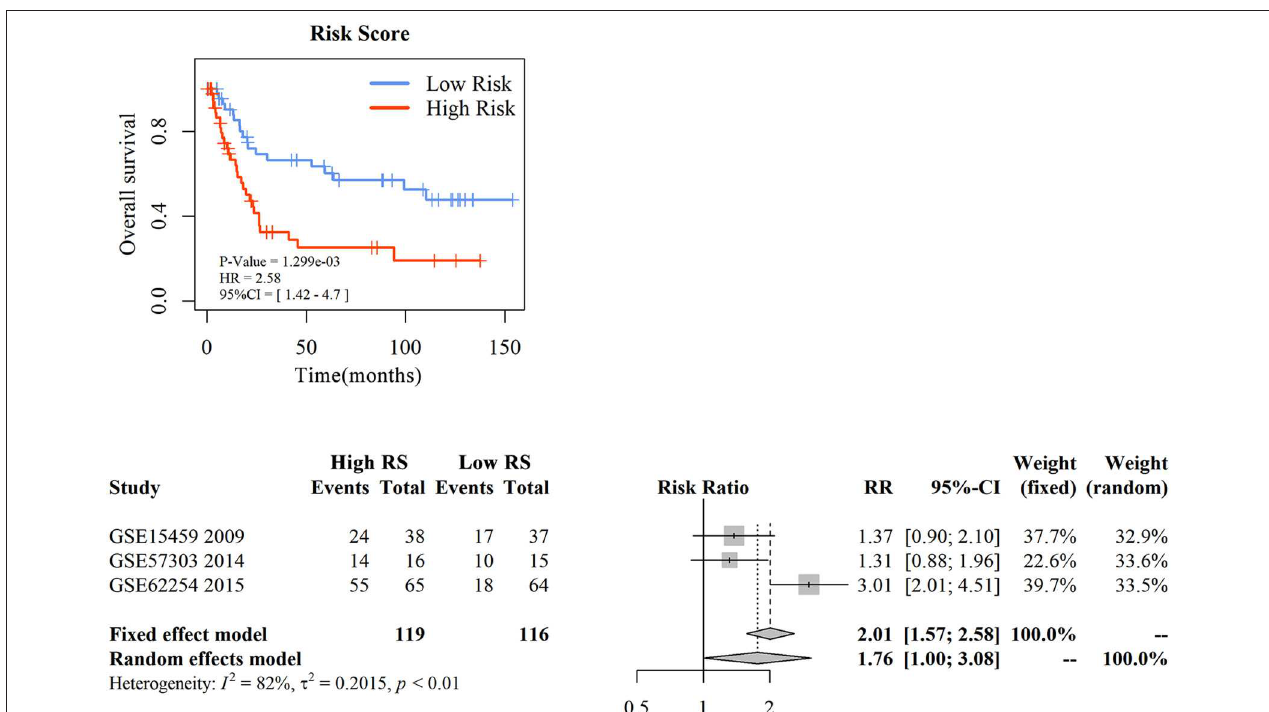
FIGURE 4 | The external validation of nomogram in diffuse type gastric cancer. KM analysis of the RS for OS in diffuse type GC in GSE15459 was based on Log-rank test (A) . A GEO meta-analysis was used to valid the predictive of the RS in diffuse type GC (B) .